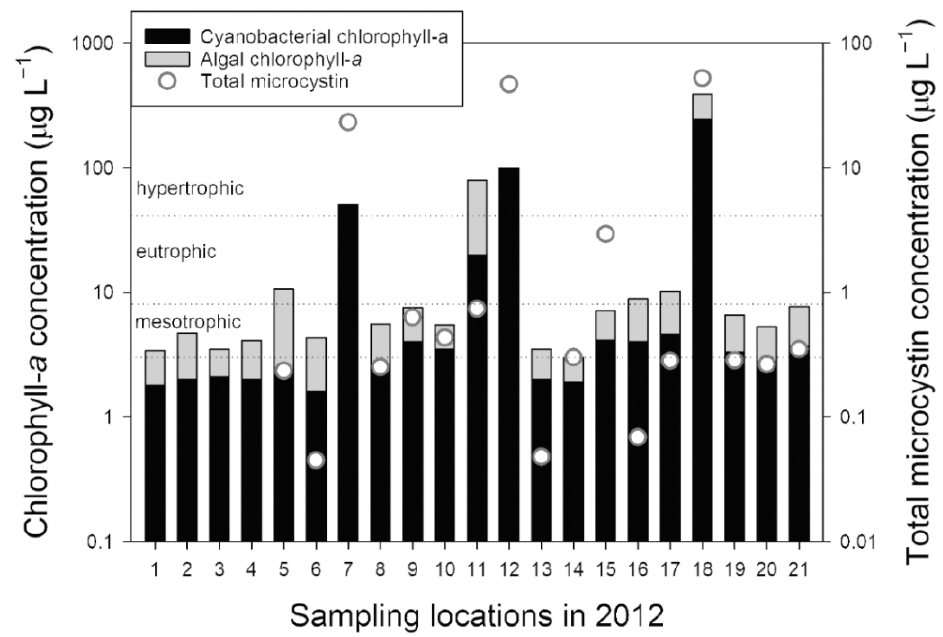
Figure 3. Cyanobacterial- (black bars) and eukaryote algal (gray bars) chlorophyll-a concentrations ( μ g L − 1 ) in samples collected on 30 and 31 August 2012 at five sites in Lake Great Prespa (1–5) and sixteen sites in Lake Lesser Prespa (6–21). The total microcystin concentrations are also shown (circles; μ g L − 1 ). The different dotted lines indicate boundaries in trophic state based on chlorophyll-a concentrations [42,43].